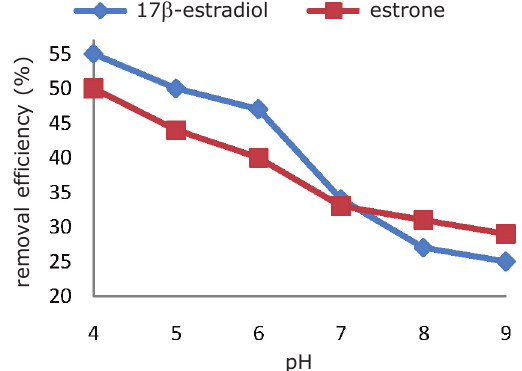
Fig. 4 – Effect of pH on the efficiency removal (%) of E2 and E1 (adsorbent dosage of 0.5 g L –1 , contact time of 30 min and 10 ng L –1 concentration of E2 and E1)